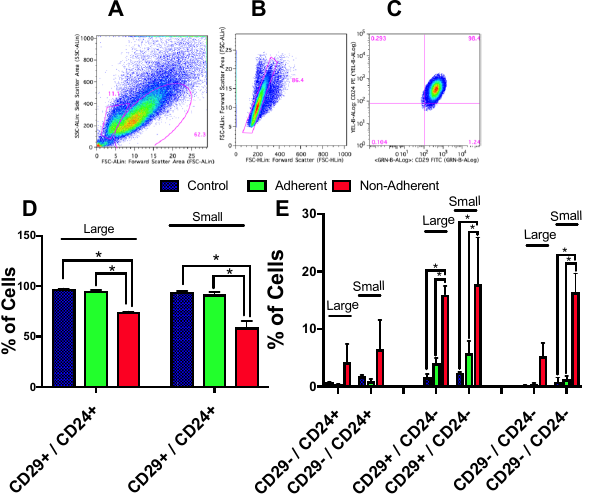
Figure 6. Stem cell markers altered following sim µg exposure. Based on FSC vs. SSC gating, two populations of cells were observed ( A ), with a smaller population falling lower on the FSC and SSC axis (small population). Doublet cells were eliminated ( B ) and the percentage of CD29 and CD24 positive or negative cells was analyzed ( C ). The majority of the population of treated and control cells (both large and small cells) were CD29+/CD24+; however, a decrease in this population was ob- served for sim-µg-treated non-adherent cells ( D ). In addition, higher numbers of CD29 − /CD24+, CD29+/CD24 − , and CD29 − /CD24 − cells were also noted in the non-adherent population, showing higher levels in the smaller population cells as compared with the larger population cells ( E ) * p < 0.05. 2.7. Three ‐ Dimensional Acini Growth Is Altered with Simulated Microgravity Exposure To de fi ne if sim µg exposure a ff ected the cell’s ability to properly form 3D structures, cells exposed to sim µg were set up in 3D cultures. Control as well as sim-µg-treated ad- herent and non-adherent cells were embedded into Matrigel independently and allowed to grow into 3D acini structures over a 6-day period. Then, 20× confocal images were taken of the stained acini, which were then analyzed using a computer software that non-sub- jectively de fi nes di ff erences in density, organization, proliferation, roundness, and vol- ume (Figure 7). Signi fi cant di ff erences were noted between non-adherent cells and both control and adherent cells in terms of density (Figure 7A,B), organization (Figure 7C,D), proliferation (Figure 7E,F), and volume (Figure 7G,H). Figures 7B,D,F,H show the binned cell populations, revealing that, in some cases, although the overall mean is similar for control and sim-ug-treated adherent cells, there are unique di ff erences in sub-popula- tions, with the sim-µg-treated population often showing a bimodal distribution, unlike the more bell-shaped population revealed in the control.